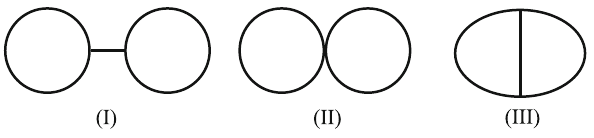
Fig. 1 Three possible structures for a topology (diagram) containing at least one LQ and one DM at the two-loop level. Note that the particle connecting the two loops in structure (I) must be colorless